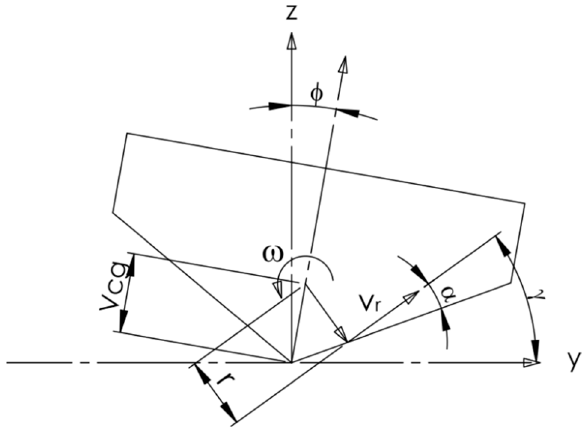
Figure 4. Asymmetric impact with rotational motion.